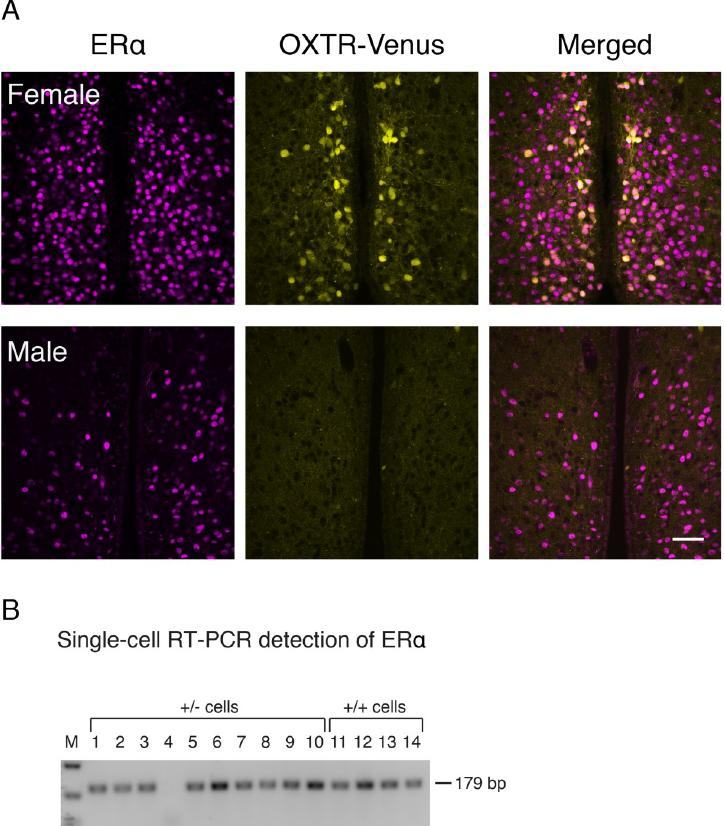
Fig 5. OXTR-Venus cells in the AVPV express ER α . A. Double confocal fluorescence photomicrographs of ER α immunoreactivity and OXTR-Venus from a female and a male OXTR-Venus (+/-) mouse. Many OXTR-Venus cells were seen in the AVPV from the female, whereas virtually no detectable OXTR-Venus cell was found in the AVPV from the male. The merged image shows that all OXTR-Venus cells were immunoreactive to ER α . B . Single-cell RT-PCR analysis of ER α expression in OXTR-Venus cells. The same set of cDNA derived from individually harvested OXTR-Venus cells used in Fig 2A was used. ER α mRNA was detected from all cells except cell #4.